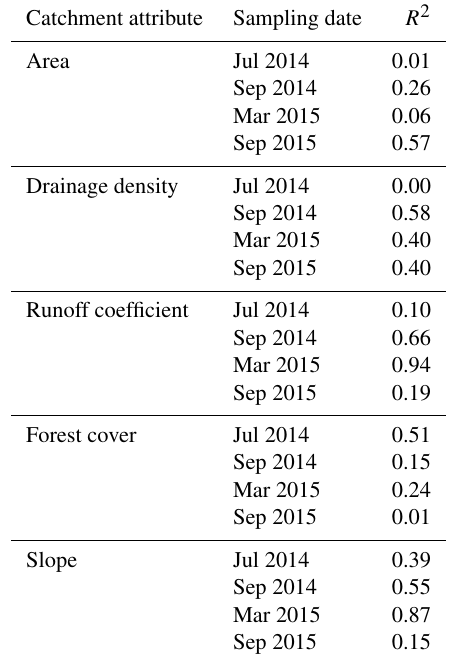
Table 2. Correlation between catchment attributes and 3 H activities for the upper Gellibrand River